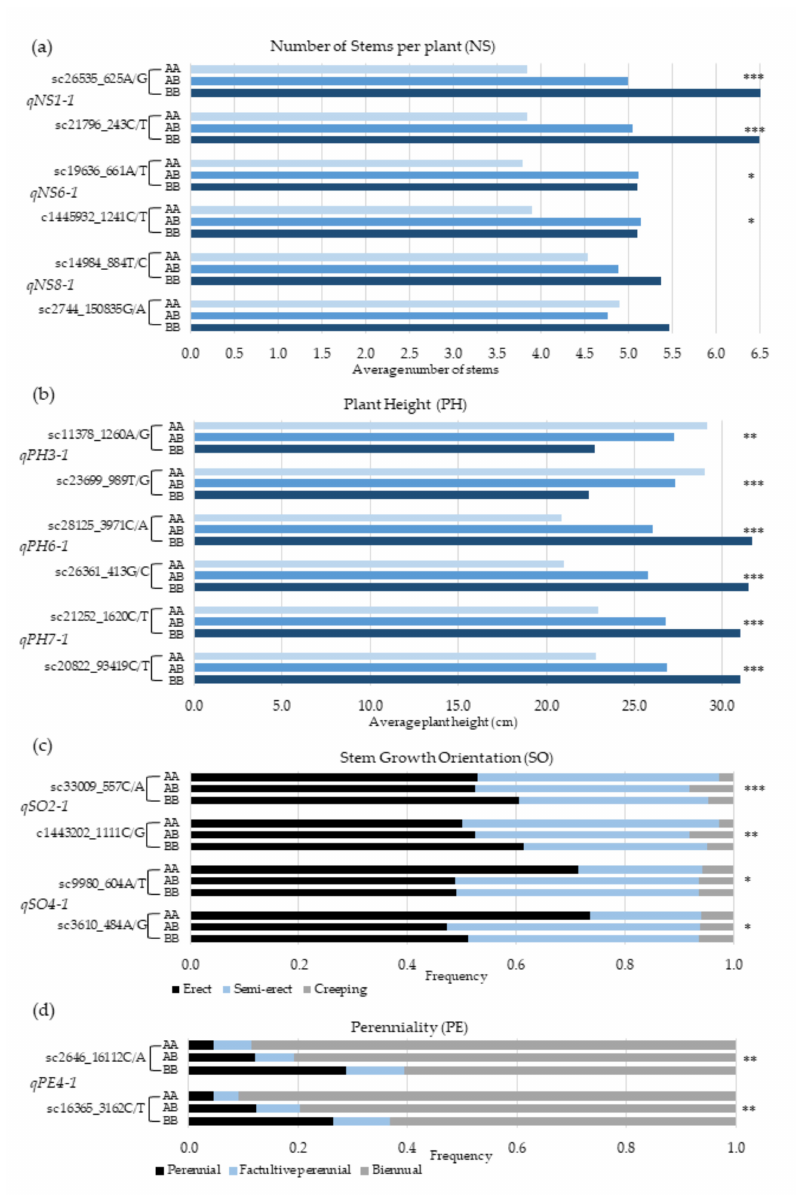
Figure 4. QTL e ff ects expressed as di ff erences in phenotypes for each genotype of each locus. ( a ) QTL e ff ects expressed as di ff erences in average number of stems per plant (NS) for each genotype of the linked markers, flanking the three QTLs on each linkage group (LG1, LG6, and LG8. ( b ) QTL e ff ects expressed as di ff erences in average plant height (PH) in cm for each genotype of the markers, flanking the QTLs on LG3, LG5, and LG7. ( c ) QTL e ff ects expressed as di ff erences in frequency of erect, semi-erect, and creeping stem growth orientation (SO) for each genotype of the markers, flanking the two QTLs on LG2 and LG4. ( d ) QTL e ff ects expressed as di ff erences in frequency of perennial, facultative perennial, or biennial types of life cycle (PE) for each genotype of the markers, flanking the QTL on LG4. The asterisks denote the statistical significance level of the variance (* = 0.05 < p < 0.01; ** 0.01 < p < 0.001; *** = p <